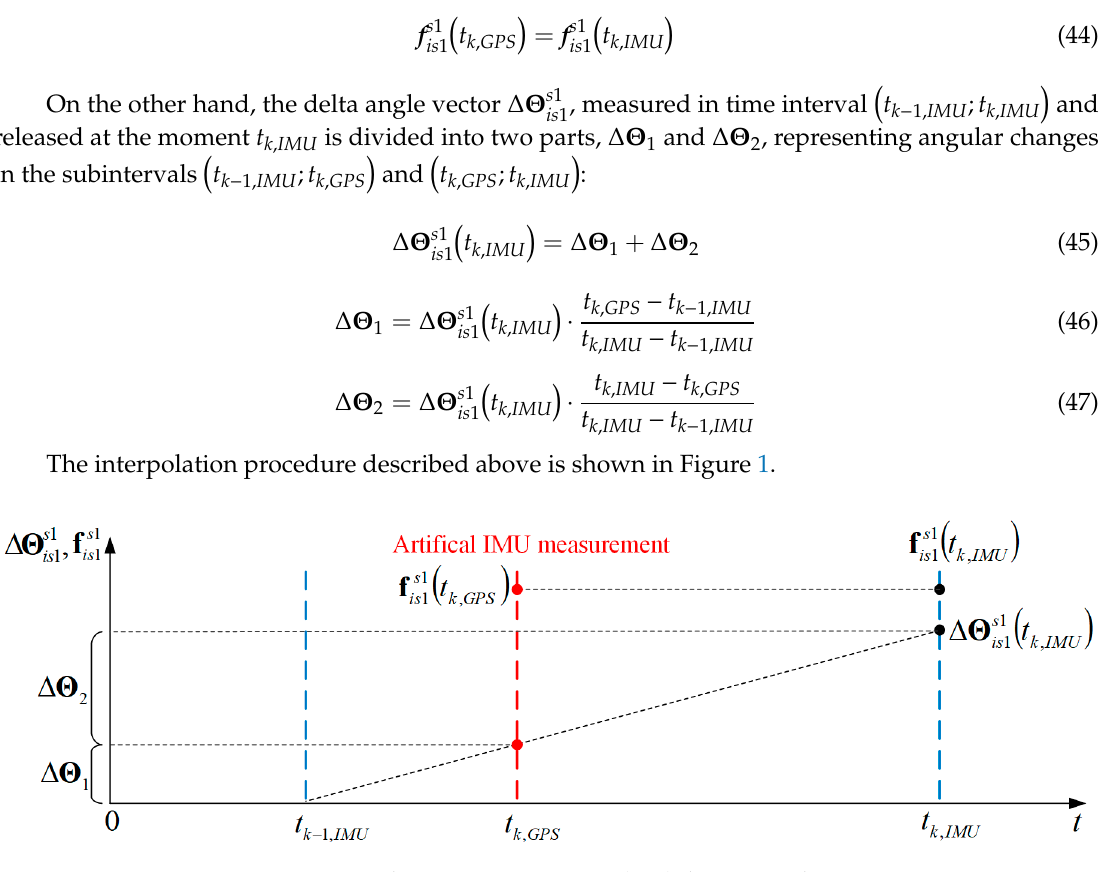
Figure 1. Inertial Measurement System (INS) data interpolation.